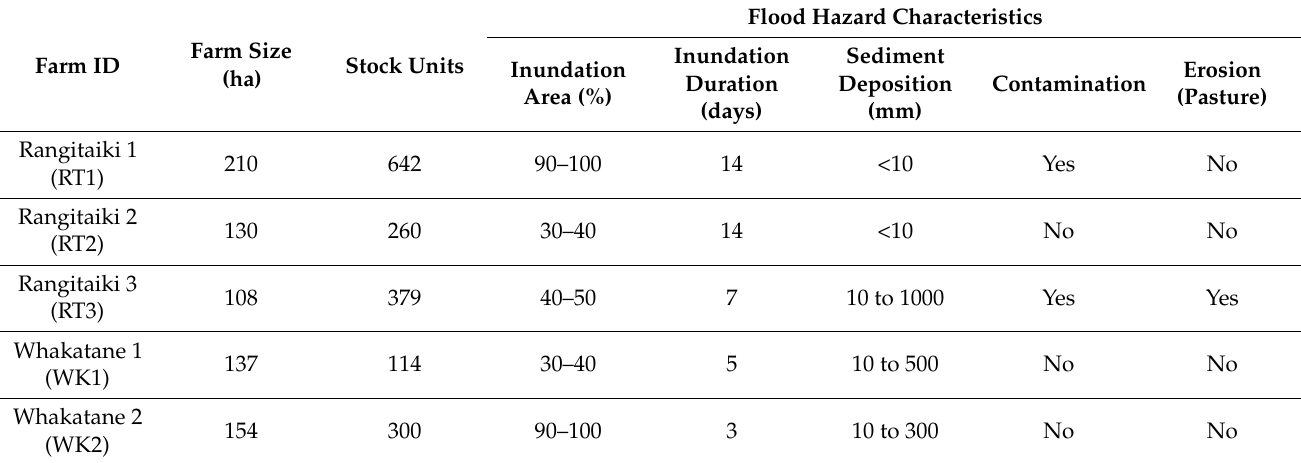
Table 1. A summary of dairy farm attributes and on-farm flood hazard